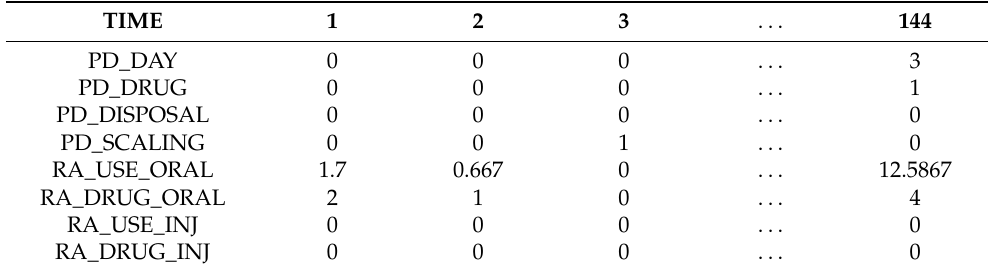
Table 5. The disease course matrix representation of the patient whose ID was 791f (one month is the unit of a time series data, k = 1).